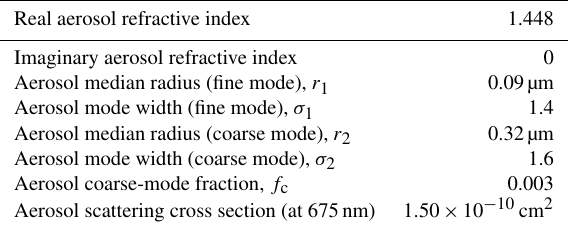
Table 1. Aerosol optical properties and aerosol size distribution (ASD) assumed in the V1 OMPS LP aerosol extinction retrieval.